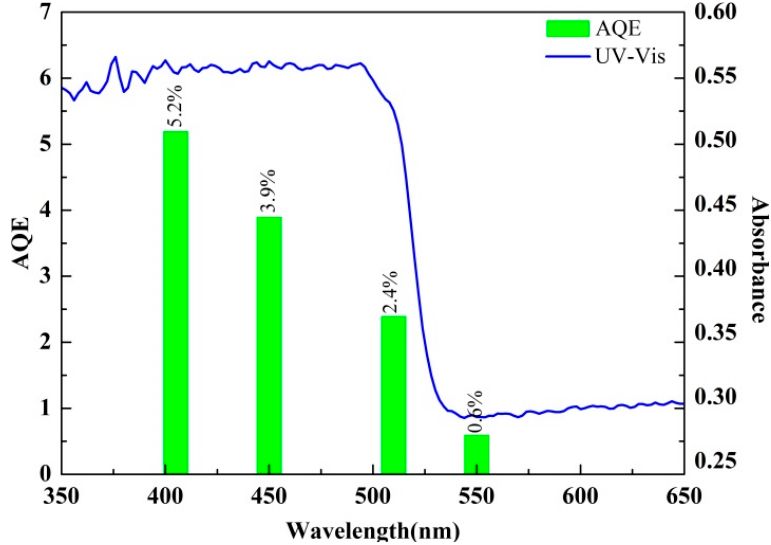
Figure 11. AQE of CdS NRs-PANI (3%)-SiO 2 (20%) at different wavelengths.